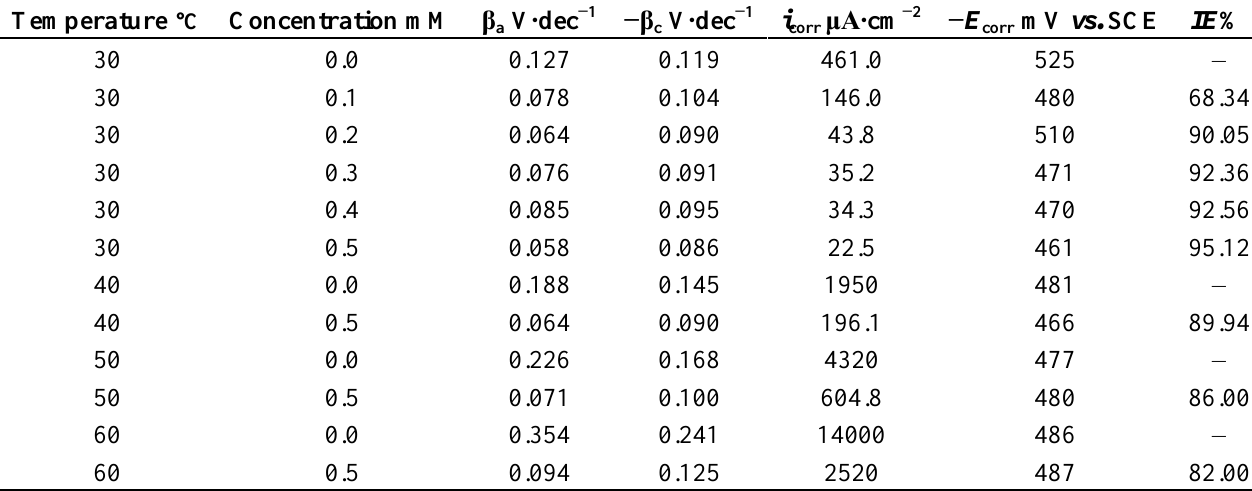
Table 1. Polarisation parameters for mild steel in 1.0 M HCl with various concentrations of PBB at different temperatures.